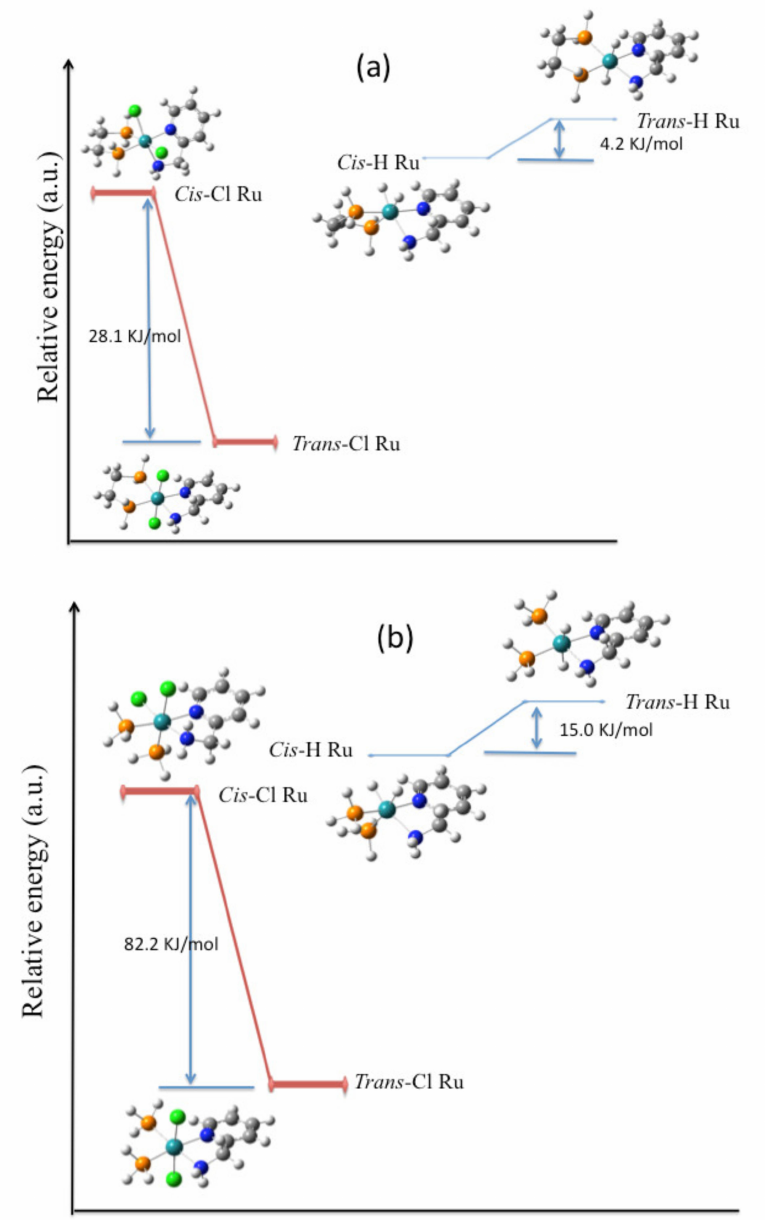
Figure 6. Relatively energy of conformation changes for bidentate ( a ) and monodentate ( b ) phosphine ligands bonding to ruthenium Picam complexes, as calculated by the DFT Gaussian